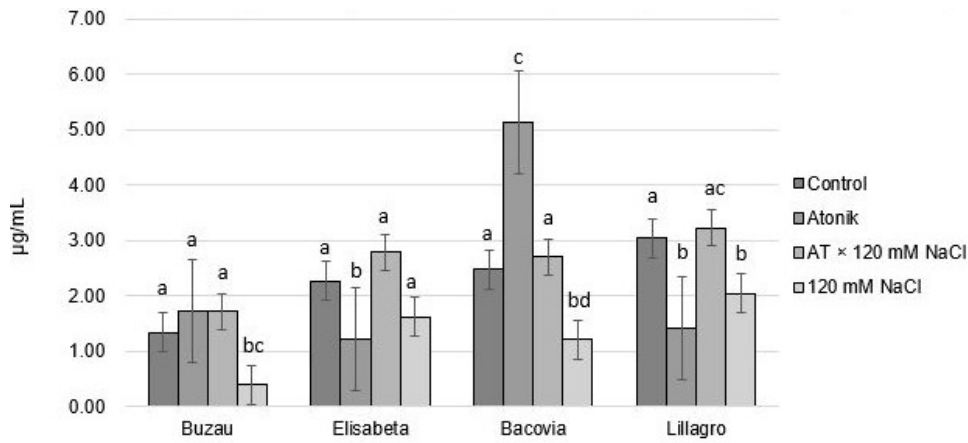
Figure 8. The effect of Atonik biostimulant on the concentration of chlorophyll b under saline stress after the third treatment. Different letters mean significant differences, according to the Tukey test. Error bars indicate ±